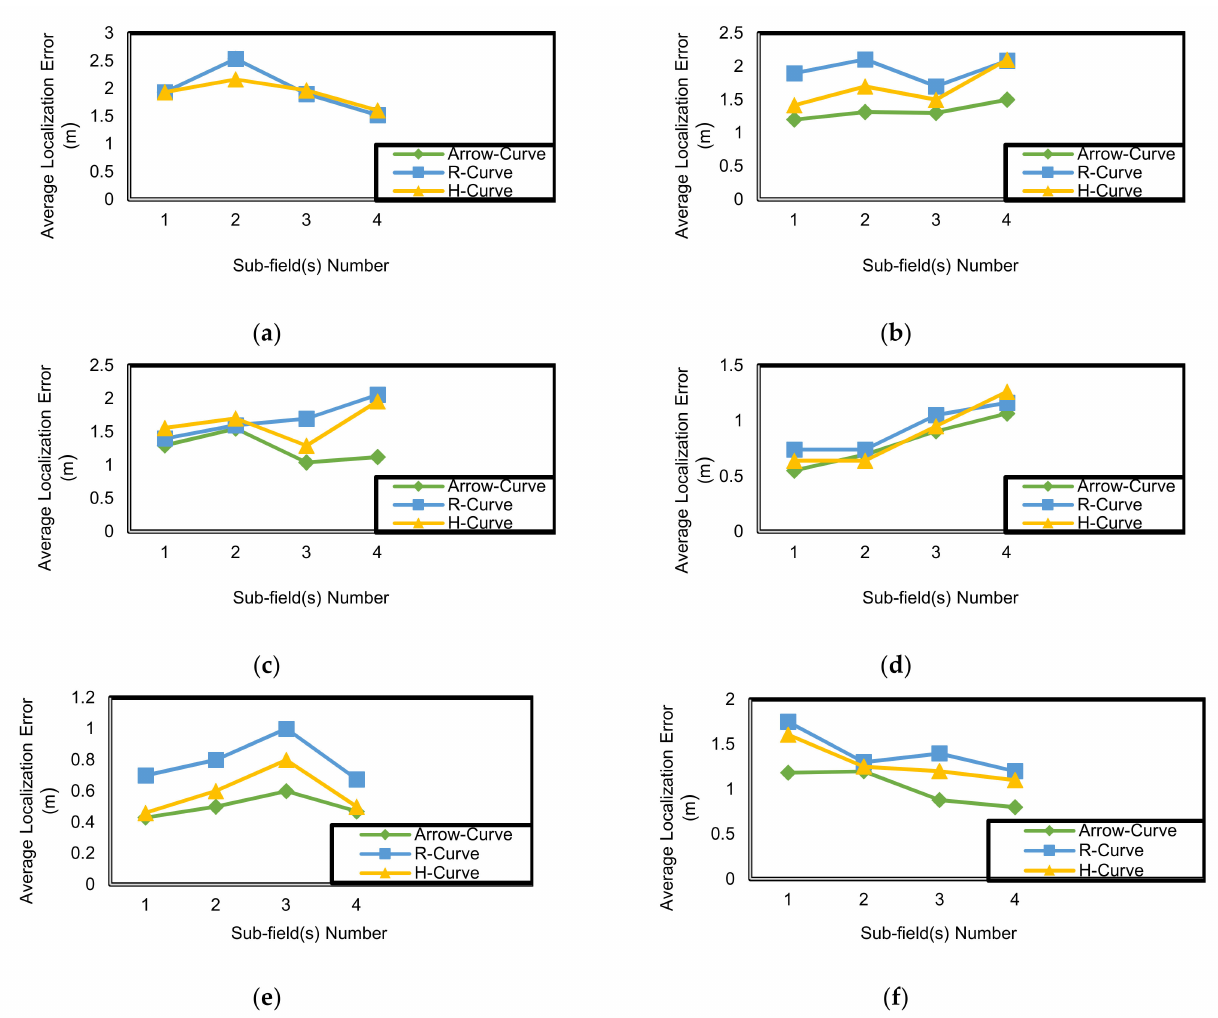
Figure 19. Average localization error (m) corresponding to sub-field (S) number at resolution (L) in outdoor environment: